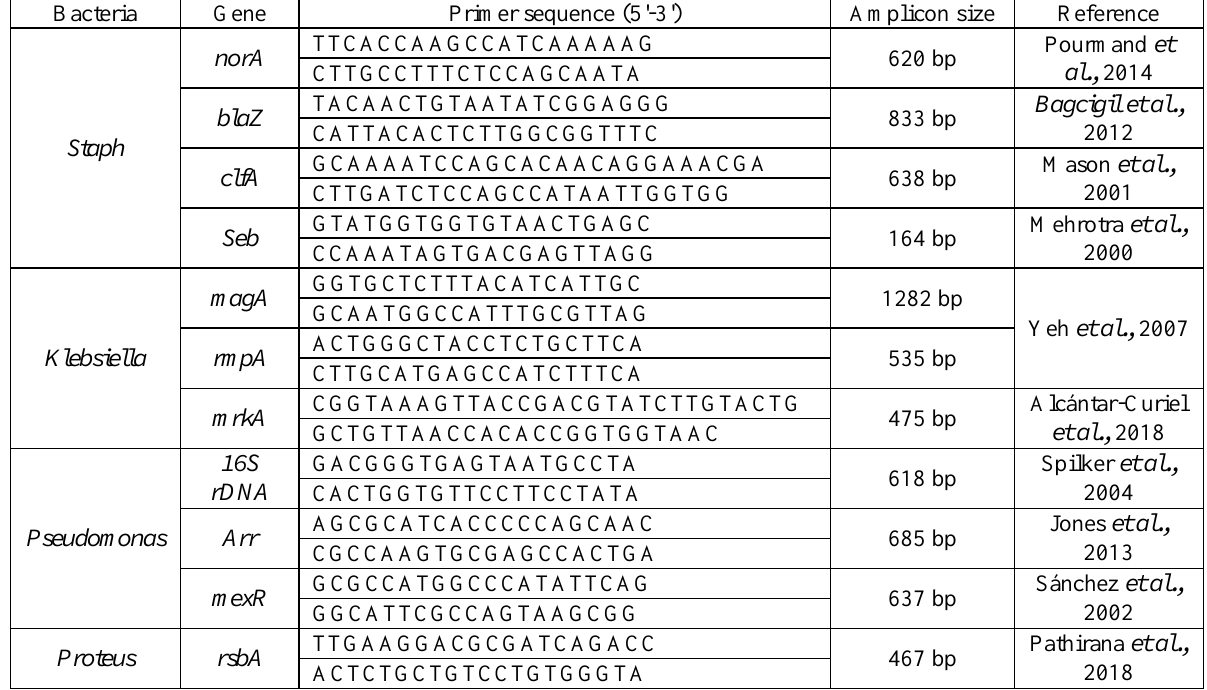
Table 1: Oligonucleotide primers sequences and amplicon sizes of the PCR targeted genes Bacteria